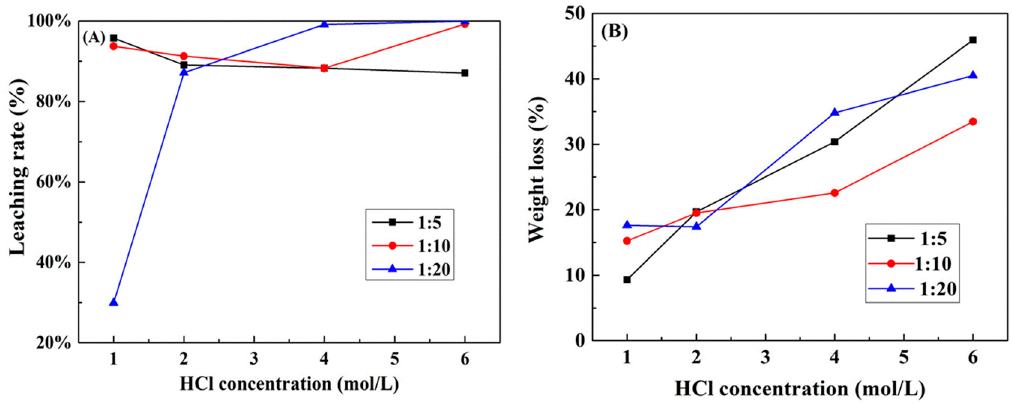
Figure 5. Effect of solid/liquid (S/L) ratio and HCl concentration on ( A ) Pt leaching rate and ( B ) weight loss of spent catalysts (Calcination temperature 800 ◦ C, 10% H 2 O 2 /spent catalysts = 0.6 mL/g, total (Cl − ) 6 mol/L, leaching temperature 90 ◦ C, leaching time 2 h).